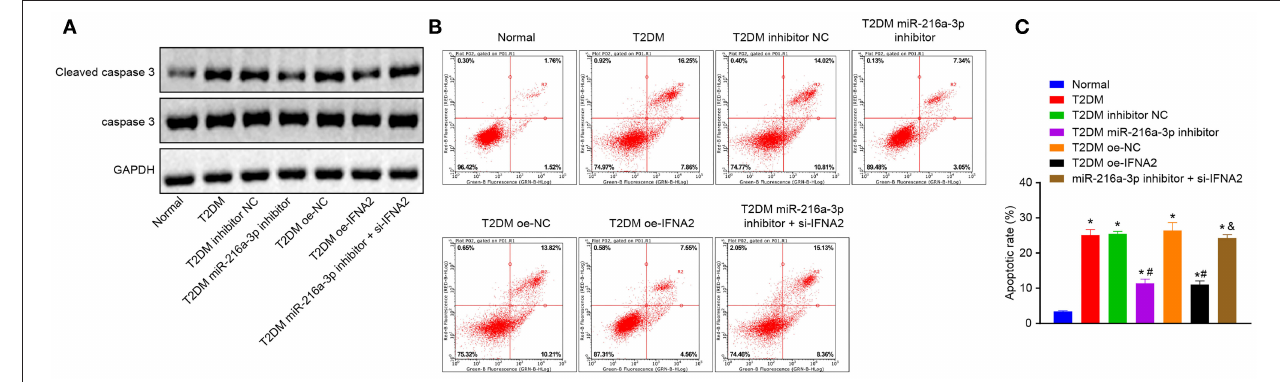
FIGURE 6 | miR-216a-3p targeted IFN- α 2 to promote apoptosis of cardiomyocytes. (A) The results of apoptosis-related gene Cleaved caspase3 and caspase3 expression measurement in rat cardiomyocytes; (B,C) apoptosis of cardiomyocytes and statistics of apoptosis rate detected using Annexin-V–fluorescein isothiocyanate apoptosis flow cytometry; * p < 0.05 vs. the normal group; # p < 0.05 vs. the T2DM/T2DM inhibitor NC/T2DM oe-NC group; & p < 0.05 vs. the T2DM miR-216a-3p inhibitor group. The data were measurement data and presented by the mean ± standard deviation and analyzed by one-way ANOVA. The experiment was repeated three